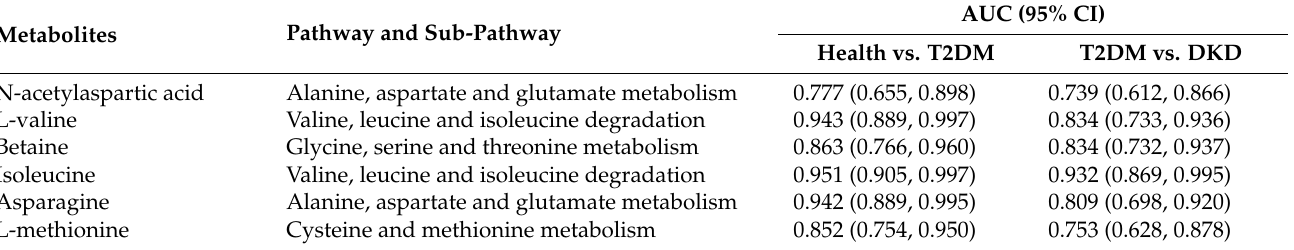
Table 3. The diagnostic power of different metabolite biomarkers in differentiating T2DM from Health controls or DKD from T2DM.